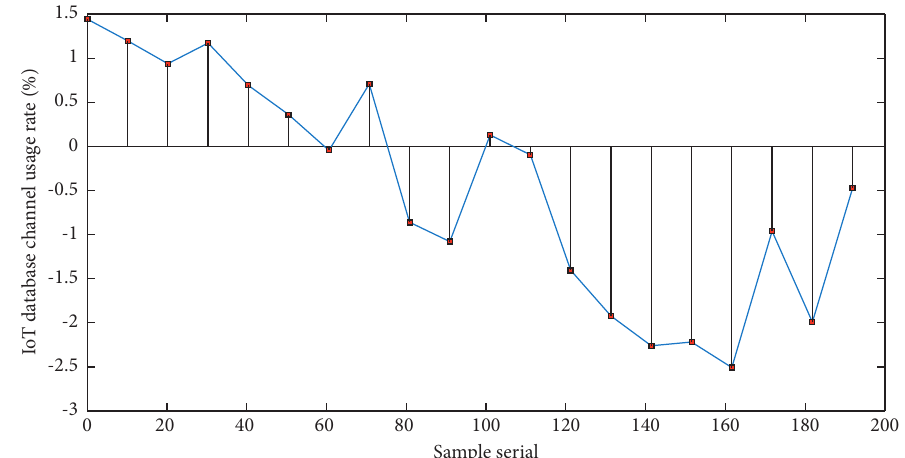
Figure 7: Channel utilization rate of Internet of Things database.